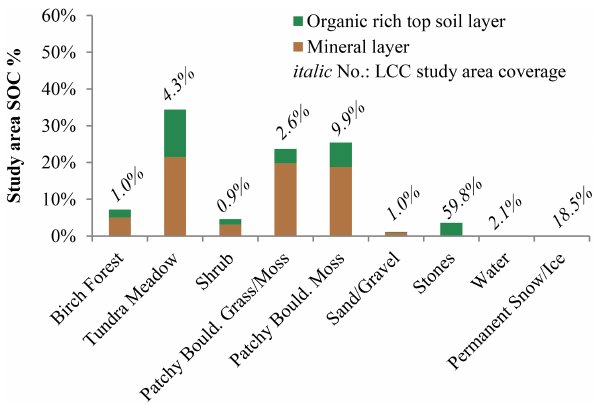
Figure 2. Partitioning of total SOC storage and proportional area coverage of land cover classes in Tarfala Valley (31.2km 2